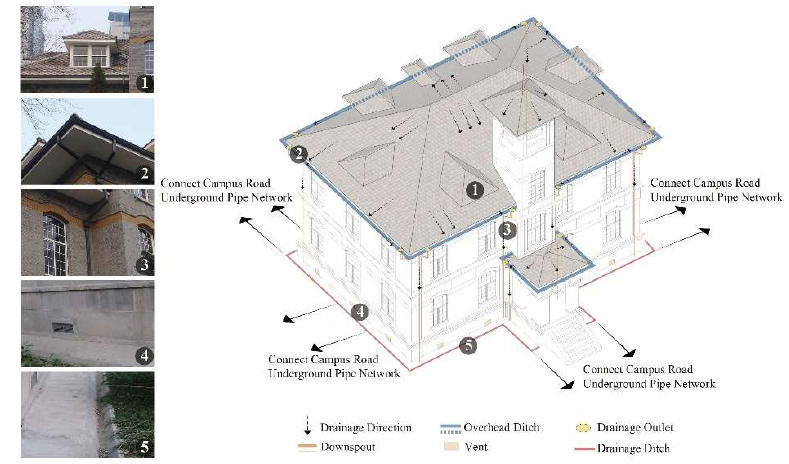
Figure 13. Water drainage system (source: author).